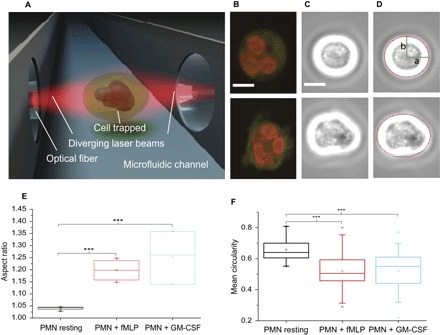
Morphological changes in activated neutrophils.(A) OS with two counterpropagating laser beams emanating from single-mode optical fibers, enabling contactless morphometry. (B) Confocal images of Syto 61 dye– and MitoTracker Orange–stained neutrophils. Resting cells remain round (top), whereas activated cells form amoeboid shapes (bottom). (C) Phase contrast images of cells trapped in the OS with strong white halo simplifying contour detection. (D) Morphometry using phase contrast images from (C). Edge detection algorithms are used to fit ellipses (red line) to the contours of the cells (cyan line), giving access to the semimajor and semiminor axes, a and b, respectively. (E) Plots of the aspect ratio, a/b, from the morphometry results of (D). Activated neutrophils have a significantly higher aspect ratio compared to resting neutrophils. (F) Mean circularity of F-actin cortex of cells stained with Alexa Fluor 488 Phalloidin. After fMLP and GM-CSF treatment, cellular circularity decreases significantly. ***P < 0.001 (significant difference). Scale bars, 5 μm. Both GM-CSF (10 ng/ml)– and fMLP (100 nM)–treated neutrophils have significantly (P < 0.0001) higher CD11b expression (fig. S1) and lower CD62L expression (fig. S2) compared to resting neutrophils (for details of priming, see the Supplementary Materials). In addition, intracellular ROS production was enhanced in primed neutrophils (fig. S3).